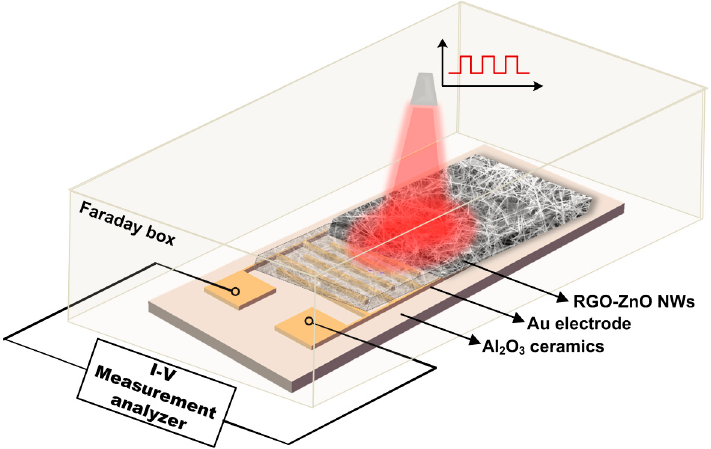
Figure 7. Schematic structure of RGO/ZNWs-based UV photodetectors and its measurement system.